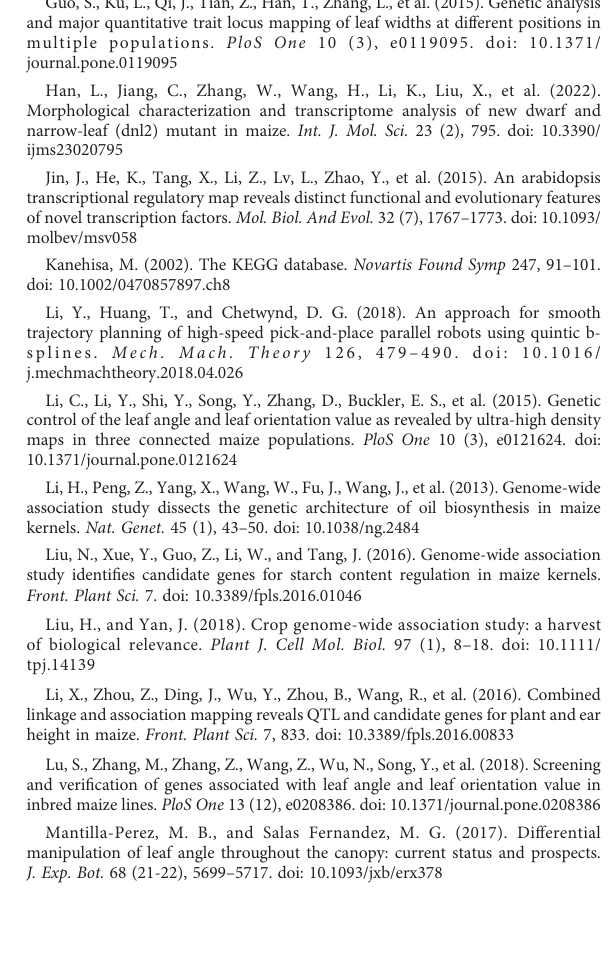
ALGORITHM FILE S1 The calculation formula of leaf midrib curve winding rate. ALGORITHM FILE S2 Algorithm fl ow of the Leaf midrib phenotype system (LMPS).